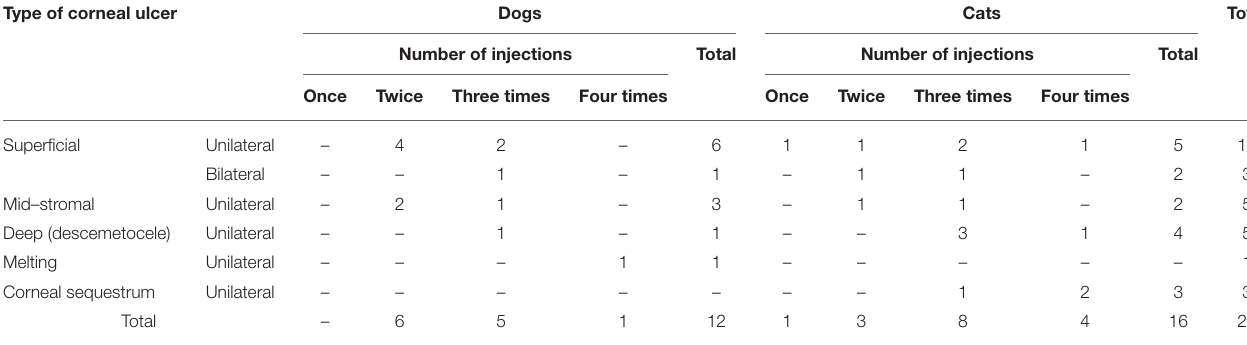
TABLE 4 | Number of injections needed for each